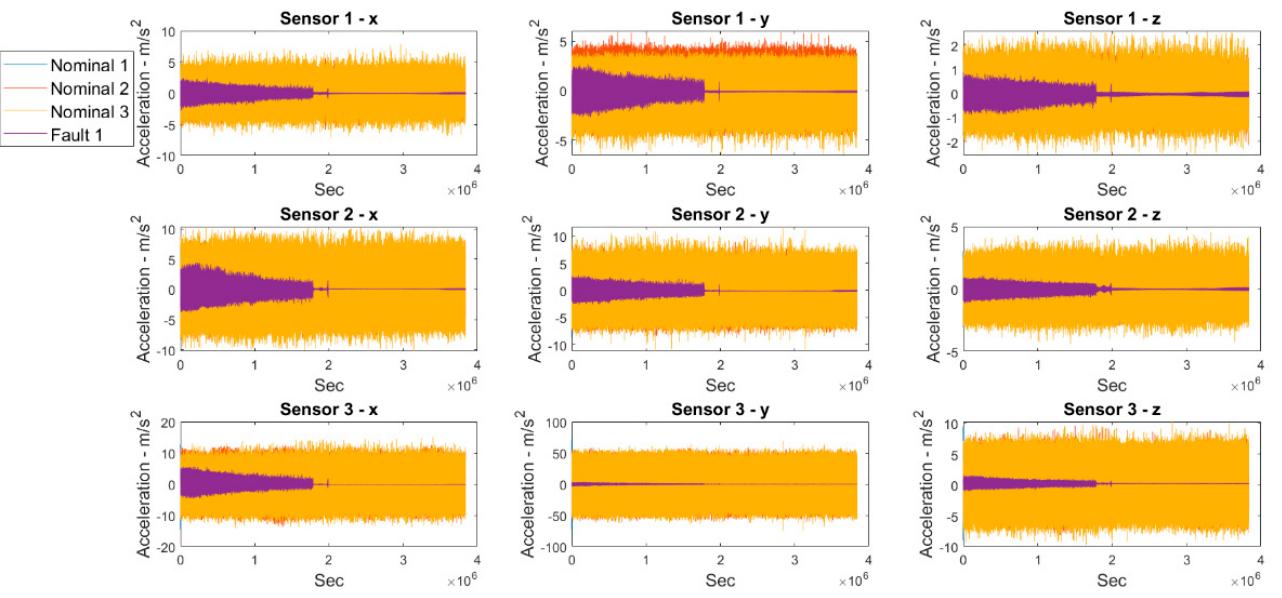
Figure 1. Raw signals generated by the system during the three nominal conditions and the fault condition.